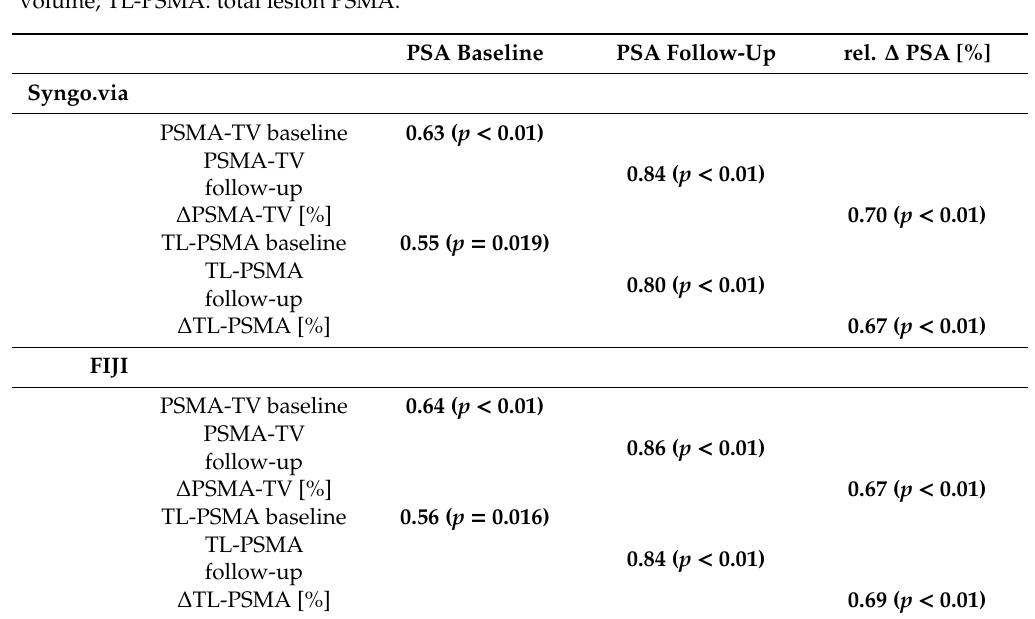
Table 3. Spearman rank correlation coe ffi cients of PSMA-TV / TL-PSMA values (baseline, follow-up, relative change) and corresponding serum prostate-specific antigen (PSA) levels—according to the software solution applied. PSMA: prostate-specific membrane antigen; PSMA-TV: PSMA tumour volume; TL-PSMA: total lesion